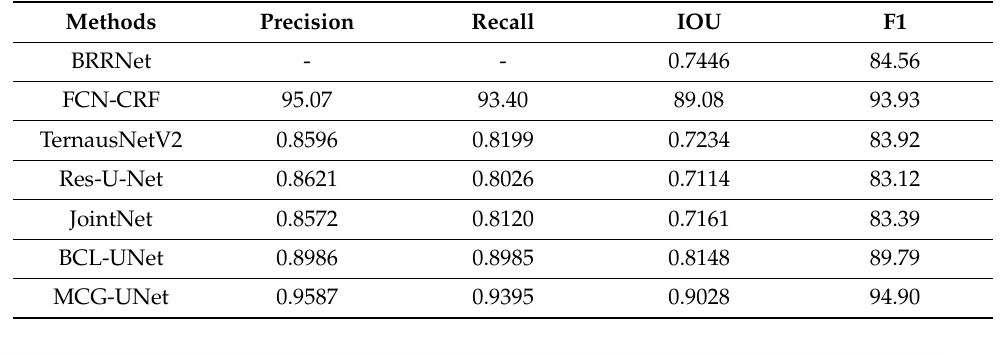
Table 5. Quantitative results generated by the BCL-UNet and MCG-UNet and other deep learning- based techniques for building extraction.